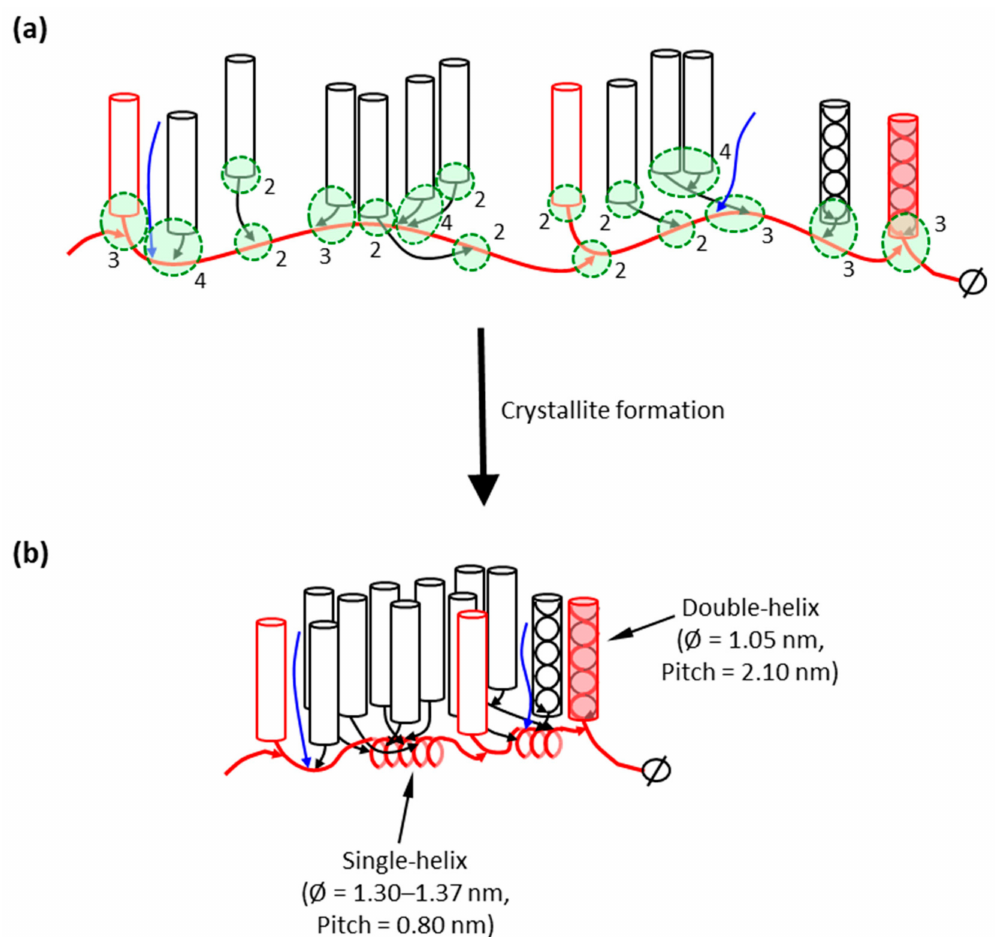
Figure 3. Amylopectin backbone structure. ( a ) The principle structure showing the backbone (red) with characteristic inter-block segments between the branched building blocks (encircled in green). Numbers indicate the groups of building blocks of which group 2 has two chains, group 3 has three chains and group 4 has four chains (the minor groups 5 and 6 are not depicted in the figure). The short chains form double-helices (cylinders). Also external segments of the long chains forming the backbone participate in double-helices (red cylinders). Some chains do not form double helices (blue chains) and presumably introduce distortions among the double-helices, which a ff ects the formation of crystallites. ( b ) The backbone is flexible and may form singe-helical segments, which contract the macromolecule and brings individual double-helices together enabling them to crystallize. To form larger crystallites with either the characteristic A- or B-allomorphs, double-helices from several individual amylopectin molecules have to come in proximity, however. The dimensions of the single- and double-helices are based on data given by Zobel et al. [112] and Imberty et al. [79],